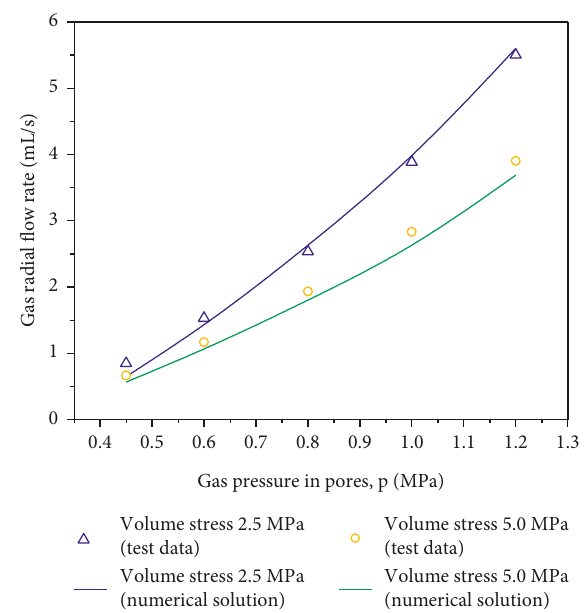
Figure 7: Comparison of test data and simulation results of gas radial flow